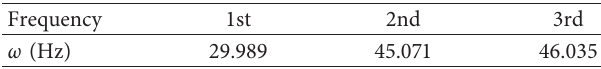
Table 1: First three natural frequencies of the intact polymer cutoff